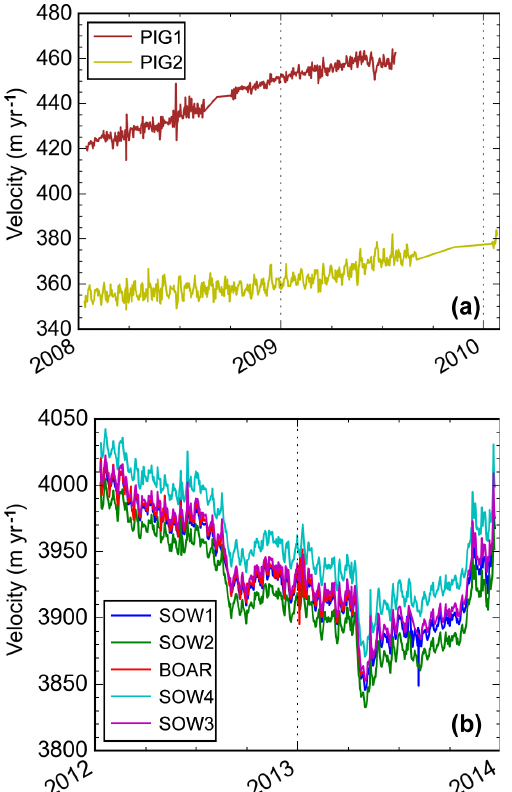
Figure 5. Station velocities derived from daily mean positions for (a) 2008–2010 GPS sites and (b) 2012–2014 GPS sites. Note offset between SOW2 and SOW4, indicative of lateral shear across the ∼ 2km wide array, with greater extension near the center of the PIG